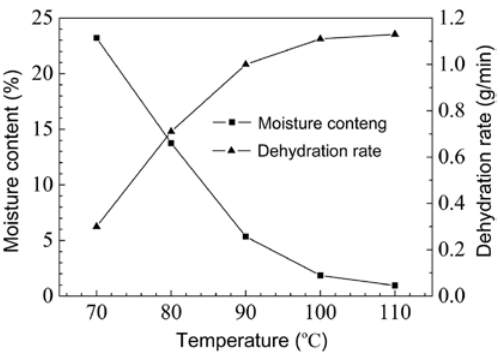
Figure 3: The effect of temperature on moisture content and dehy- dration rate of zinc oxide leach